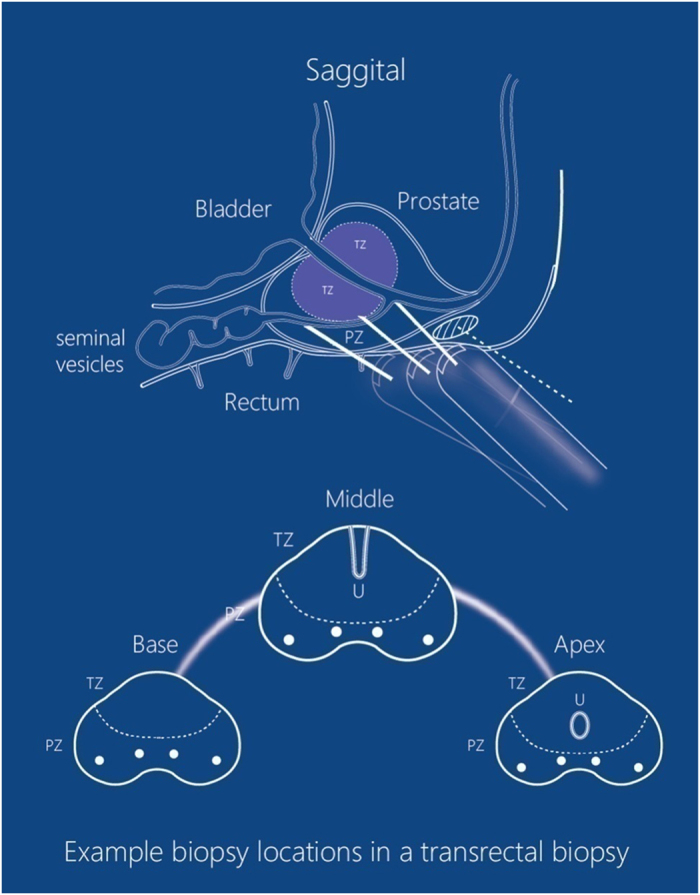
The protocol of TRBx.On saggital section, it shows that TRBx is performed in three planes of prostate (base, middle and apex plane). The depots of PPNB are apical (in the white circle with diagonals), and the routes of administration are transrectal (white dotted lines). On transverse section, it shows the protocol of biopsy in each plane (two parasagittal biopsies and two far-lateral biopsies). Four cores are sampled in base plane and four in apex planes respectively for 8-core TRBx, and another four cores are sampled in middle plane for 12-core TRBx.